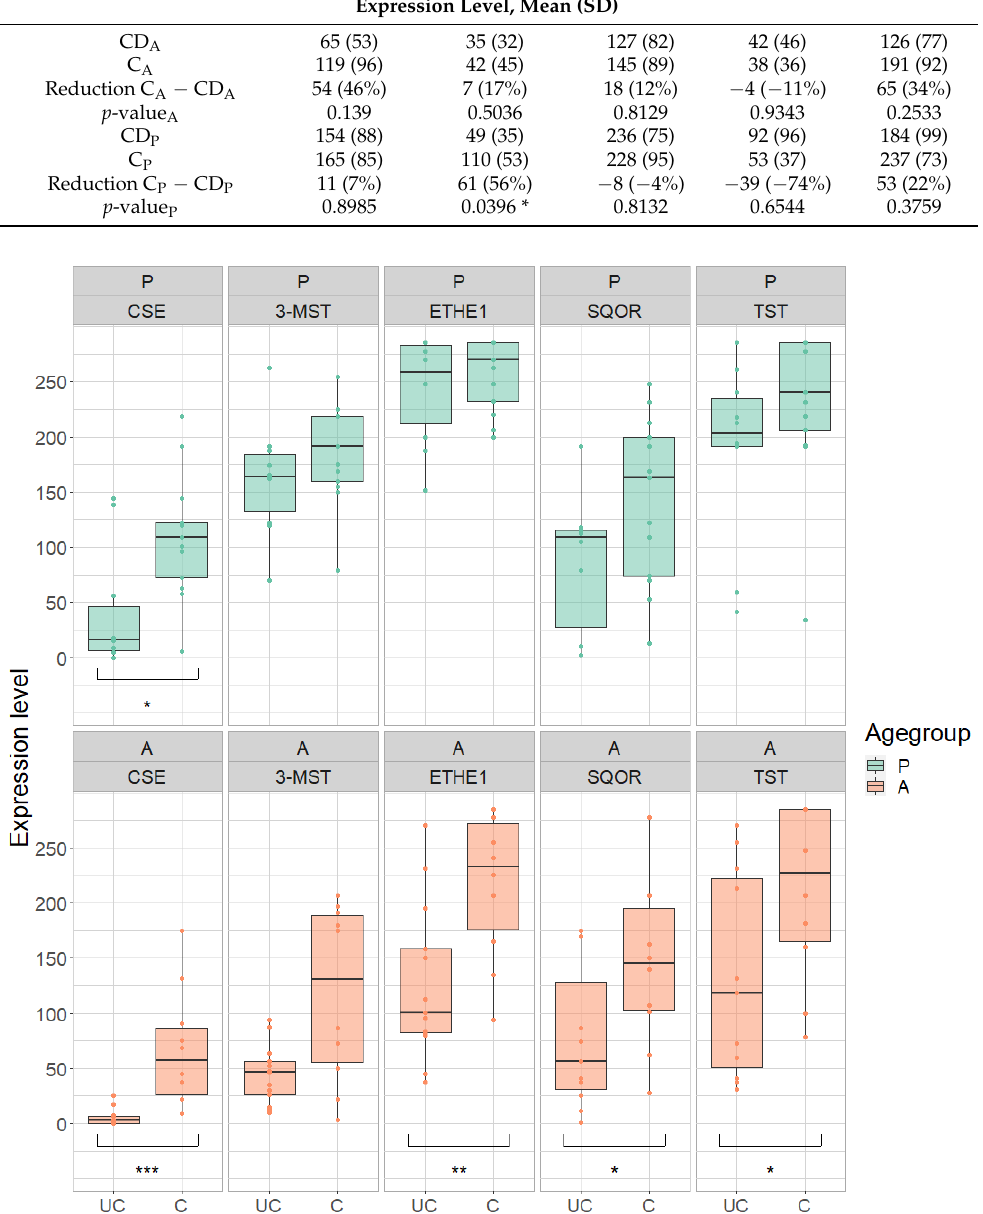
Table 5. Expression as mean with standard deviation (SD), absolute reduction and percentage as well as p -value of the terminal ileum in the Crohn’s disease group (CD) separated by age group com- pared to age matched controls (C). Pediatric (P); adult (A), cystathionine- γ -lyase (CSE), 3-mercapto- sulfurtransferase (3-MST), ethylmalonic encephalopathy 1 protein (ETHE1), sulfide:quinone oxidore- ductase (SQOR) and thiosulfate sulfurtransferase (TST). * = p -value < 0.05. CD—Terminal Ileum